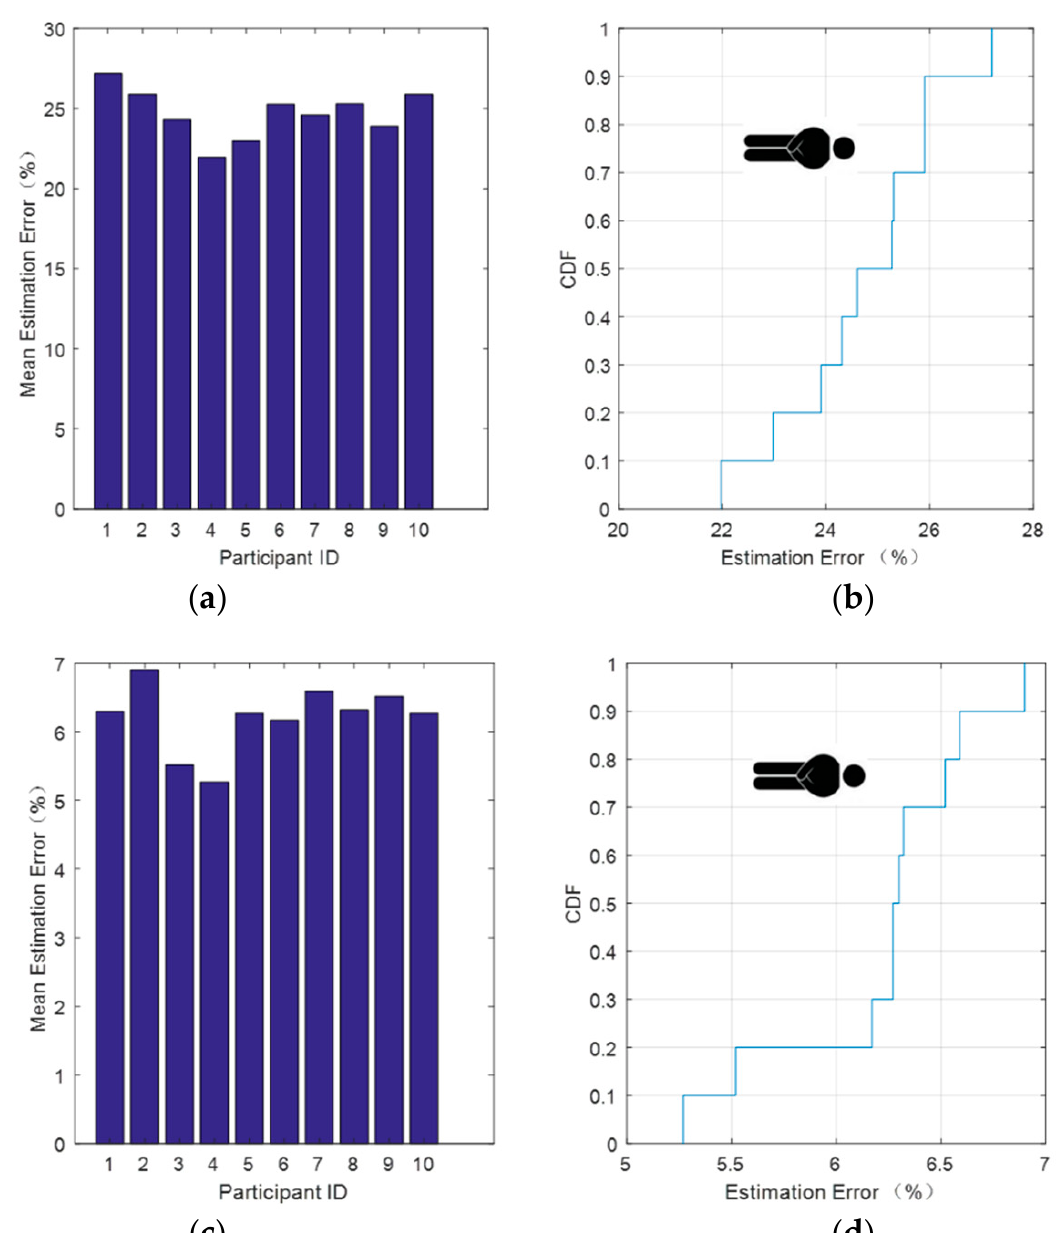
Figure 8. Respiratory signal relative error after data processing while lying down. ( a ) Average error estimate and ( b ) CDF (cumulative distribution function) of the estimated error after soft threshold denoising. ( c ) Average error estimate and ( d ) CDF of the estimated error after hard threshold denoising.